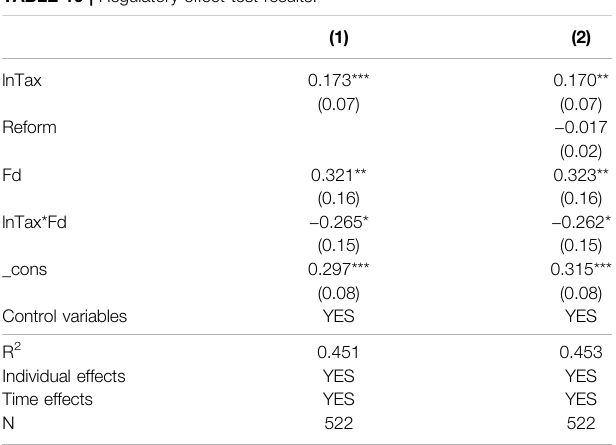
TABLE 10 | Regulatory effect test results.